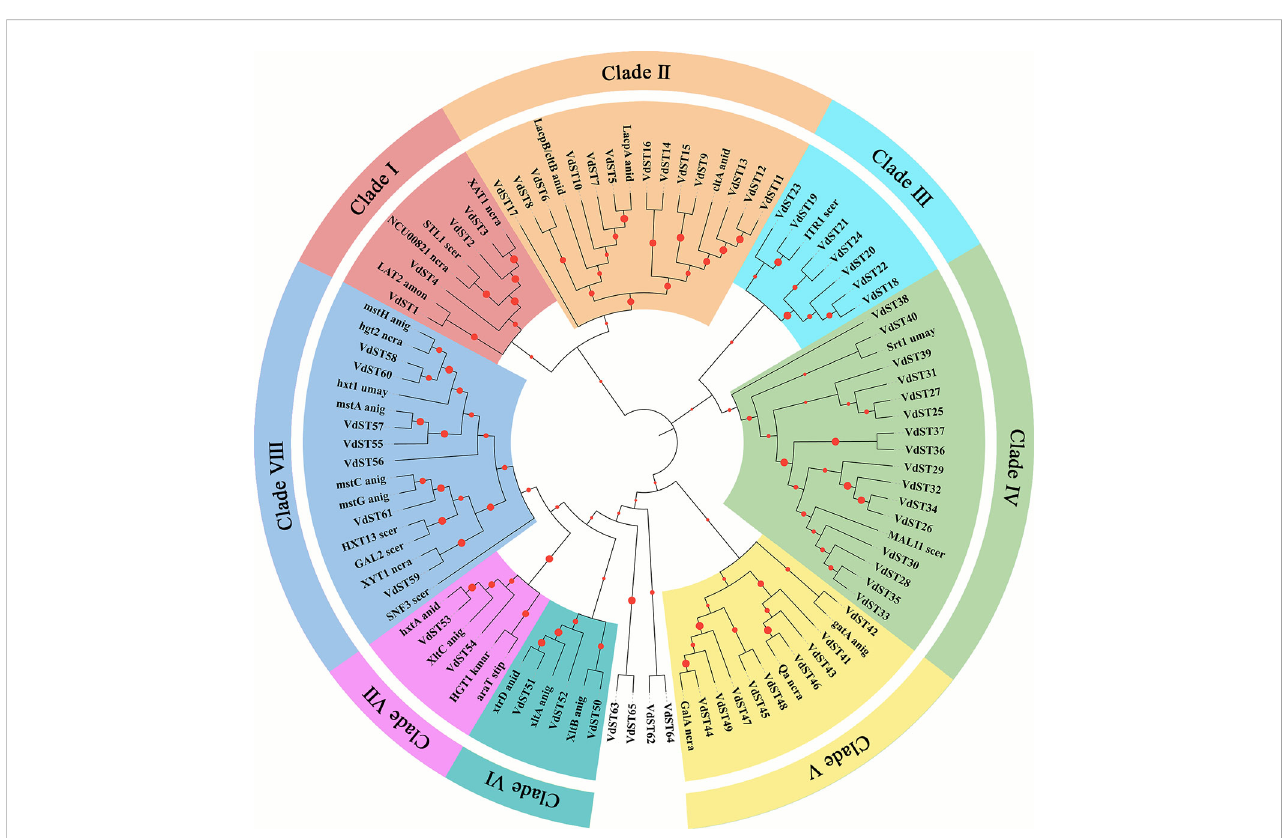
FIGURE 1 Phylogenetic classi fi cation of sugar transporters in V. dahliae . The phylogenetic tree contained 65 VdST proteins and 30 ST proteins from other fungi (Table S1). The tree was generated by MEGA 7.0 with 1000 bootstrap replications. Eight Clades were distinguished by different colors. The abbreviation of fungal species name is attached to each transporter protein (anid = Aspergillus nidulans , anig = Aspergillus niger , amon = Ambrosiozyma monospora , bcin = Botrytis cinerea , kmar = Kluyveromyces marxianus , ncra = Neurospora crassa , scer = Saccharomyces cerevisiae , spas = Saccharomyces pastorianus , stip = Scheffersomyces stipitis , umay = Ustilago maydis